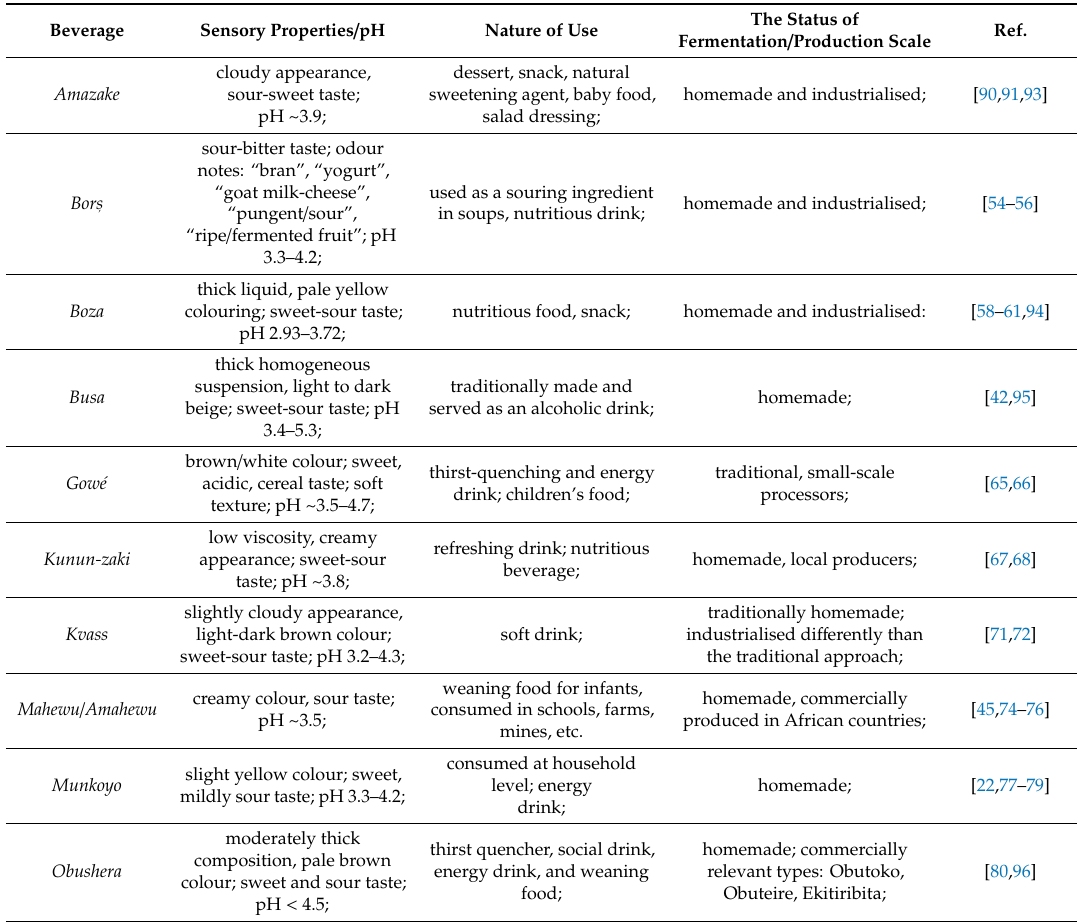
Table 2. Non-alcoholic fermented cereal beverages and their sensory properties, nature of use, and fermentation